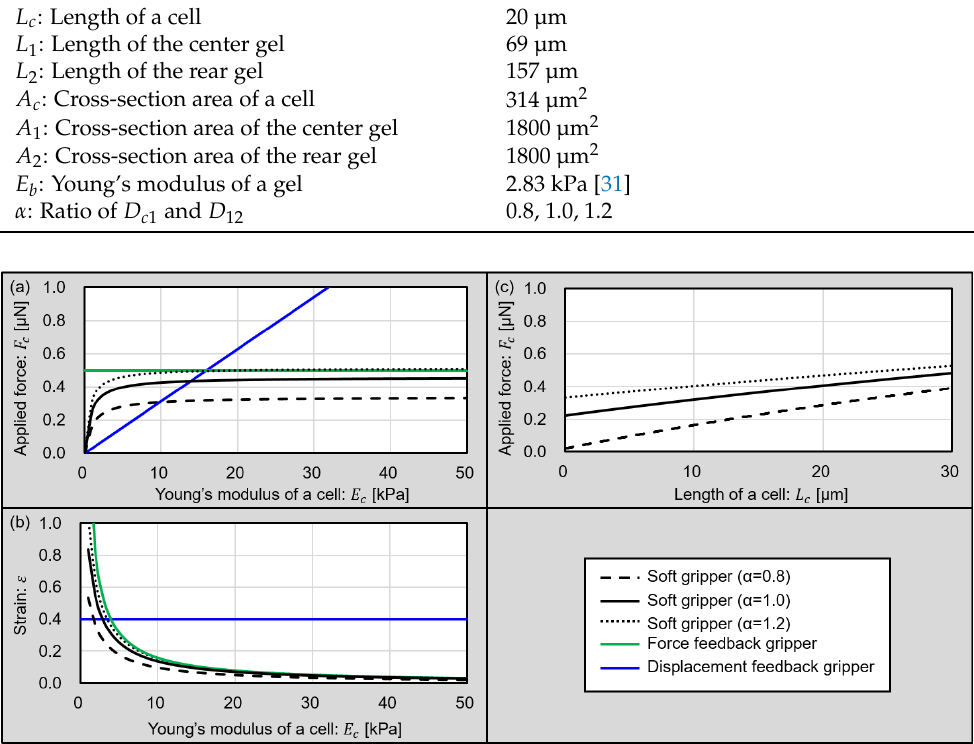
Figure 3. Plot of the theoretical analysis of grippers. ( a ) The relationship between applied forces for target cells and the Young’s modulus of the cells. ( b ) The relationship between the strains of target cells and Young’s modulus of the cells. ( c ) The relationship between applied forces for target cells and the sizes of the